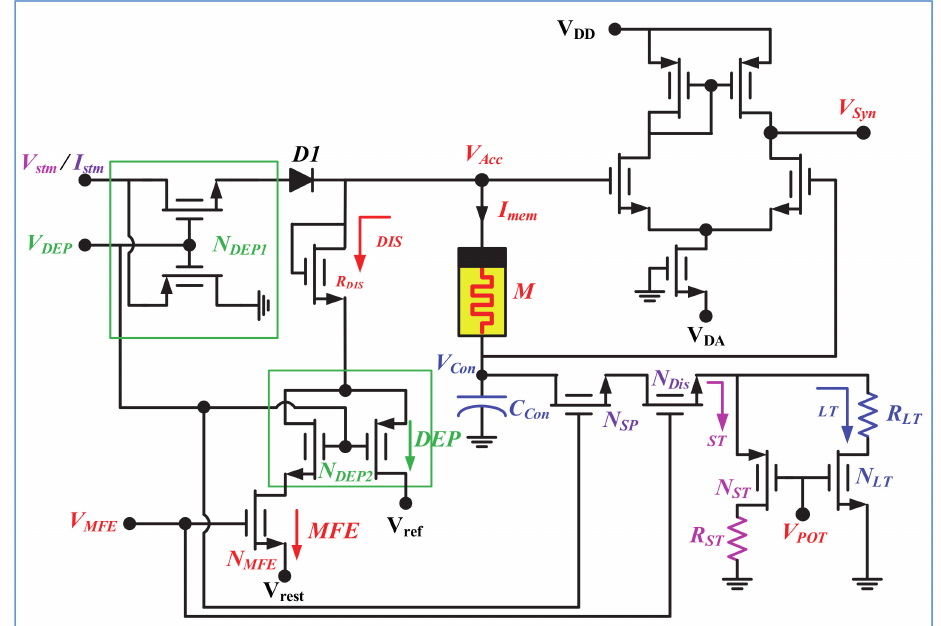
Figure 2. Proposed neuro-memristive